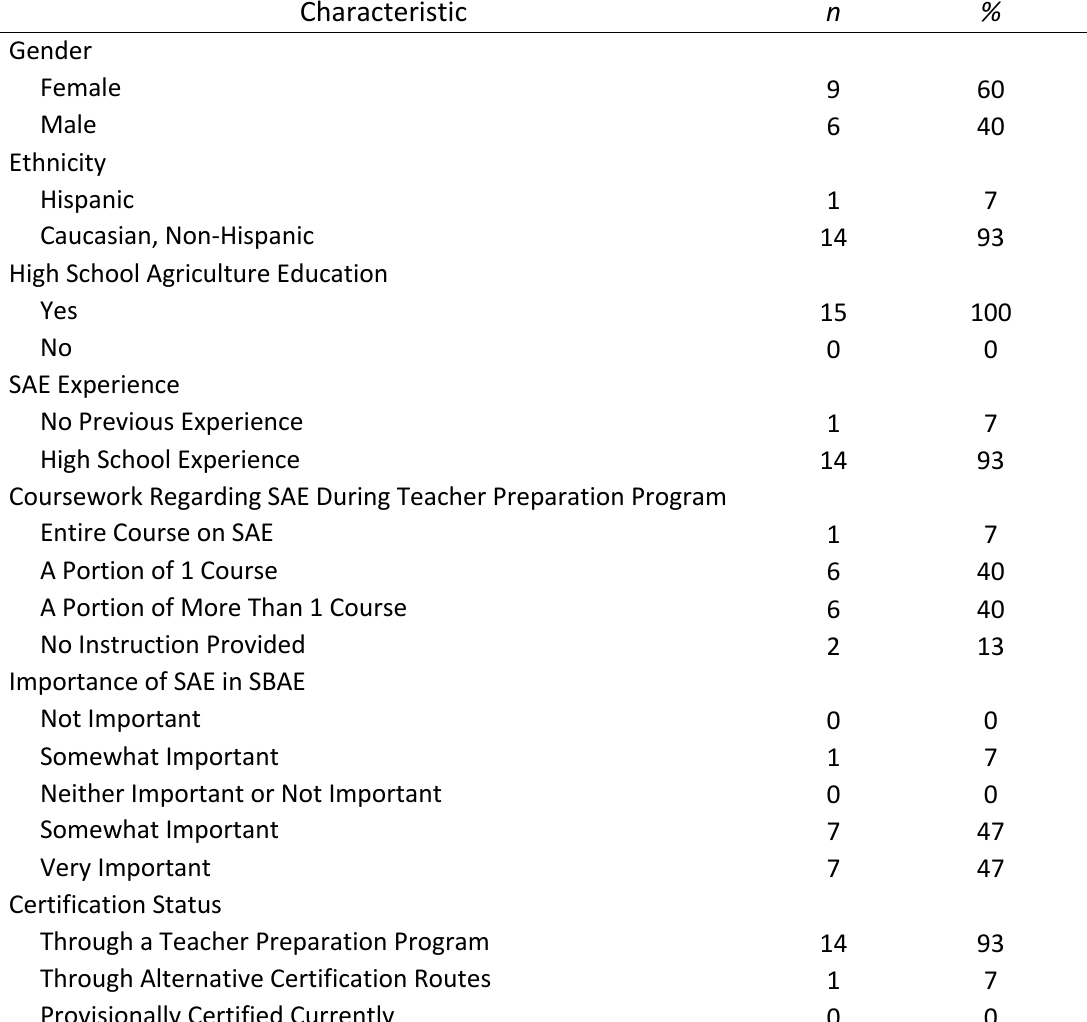
Table 1 Demographics of Preservice Teachers (n = 15)